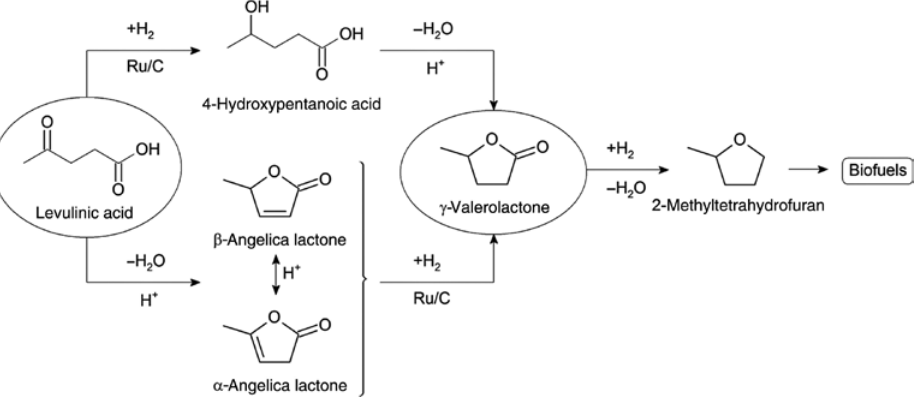
Figure 1: Levulinic acid (LA) transformation to gamma-valerolactone (GVL) and 2-methyltetrahydrofuran (2-MTHF)